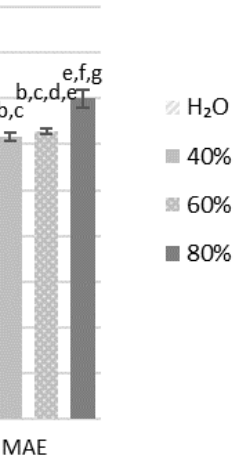
Figure 7. Antioxidant capacity of the extracts obtained from the fraction with particle size ≤ 0.5 mm determined by the FRAP method. SWE—shaking water bath extraction; UAE—ultrasound-assisted extraction; MAE—microwave assisted extraction; 15, 30 or 60-time of extraction. Results are presented as the mean ± SD from triplicate determinations. Different letters: a, b, c, d, e, f, g, h, i, j, k, l, m indicate that samples are significantly different. The letter “a” marks the lowest value. Higher values are marked with consecutive letters of the alphabet. Bars that share the same letter within the group are not significantly different according to Tukey’s HSD test at p > 0.05.